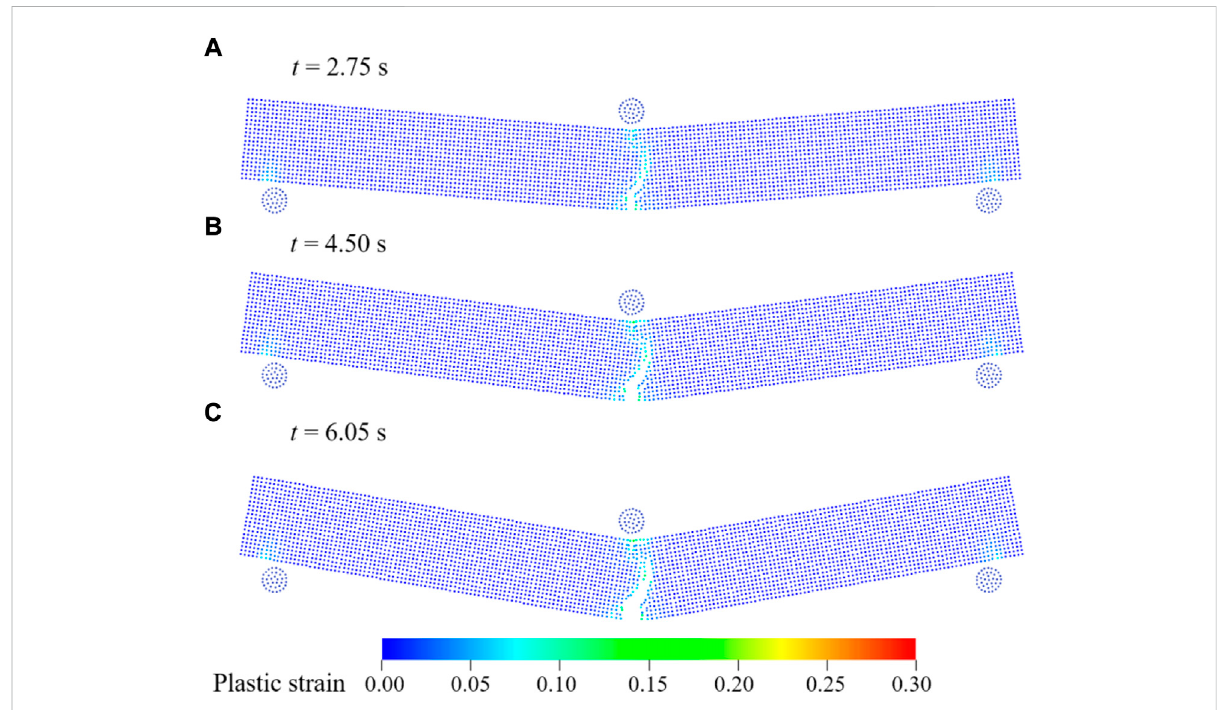
FIGURE 7 Snapshots of the ice beam in three-point bending experiment by SPH at (A) t = 2.75s, (B) t = 4.50s and (C) t = 6.05s.